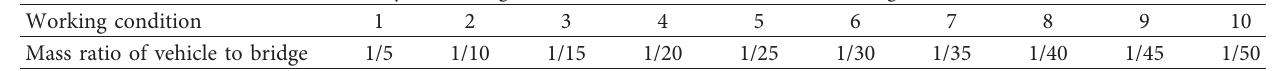
Figure 13: Deviation rate of acceleration of the bridge midspan under different models. Table 4: Analysis working conditions of different vehicles and bridge mass